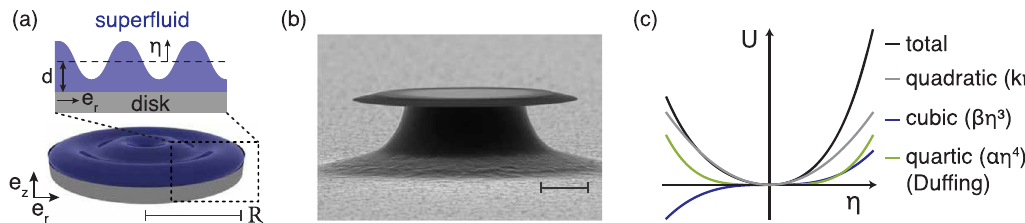
Fig. 1 Anharmonic super fl uid disk-resonator. a Illustration of a surface wave of amplitude η [ r , θ ] in a thin super fl uid helium fi lm of mean thickness d , con fi ned to a circular geometry of radius R . b Previously demonstrated experimental methods for circular con fi nement of a super fl uid helium fi lm include adsorption of the fi lm on the surface of an on-chip microdisk as shown in this SEM micrograph 38 – 40,49 , or on the inside of parallel disks of a capacitor as in refs. 70,73 . Scale bar: 5 μ m. c Anharmonic potential of a super fl uid oscillator with spring constant k , cubic nonlinear constant β , and quartic (Duf fi ng) constant α